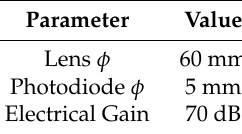
Table 6. Receiver characteristics.